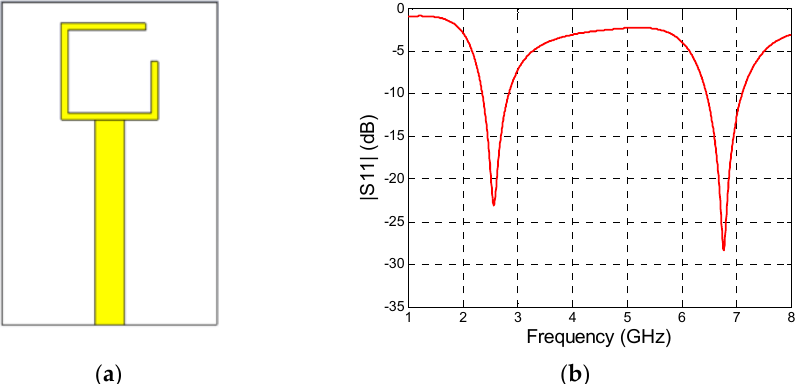
Figure 4. ( a ) The split ring resonator and ( b ) Its simulated reflection coefficient response.